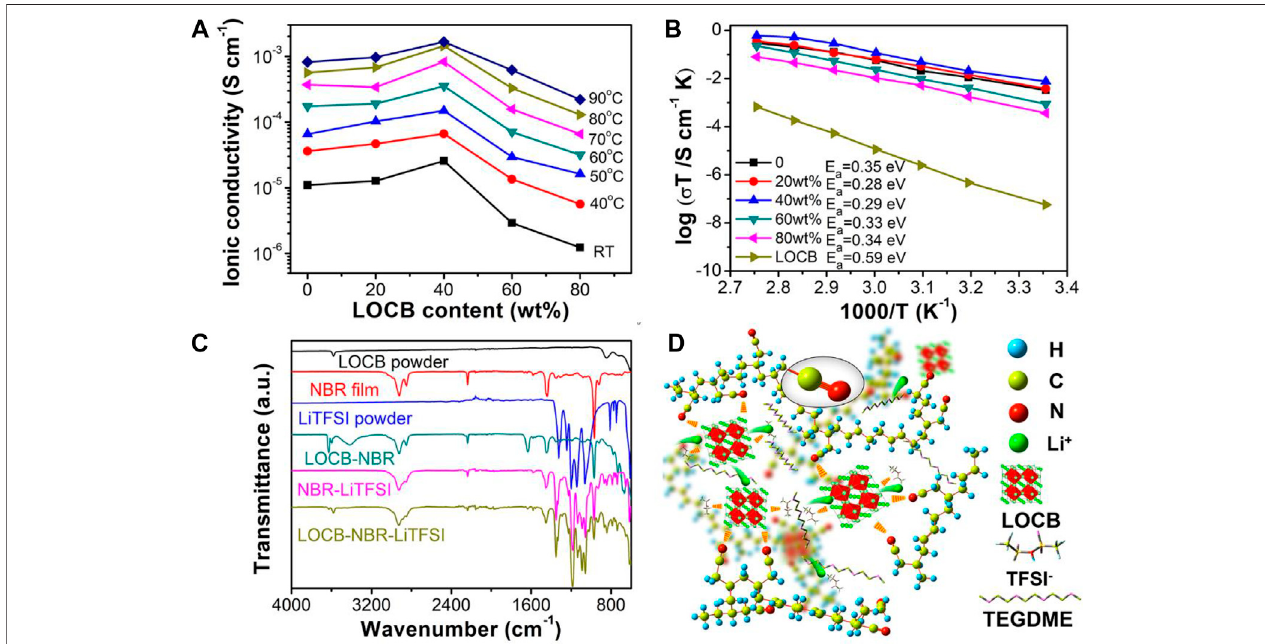
FIGURE 3 | (A) LOCB content ratio dependent ionic conductivity of the CPE fi lms at different temperatures. (B) Arrhenius plots of CPE fi lms with different LOCB content ratio. (C) FTIR spectra of the different components of LOCB/NBR CPE fi lm and their mixtures. (D) Schematic illustration of the Li ion conduction mechanism of the LOCB/NBR CPE fi